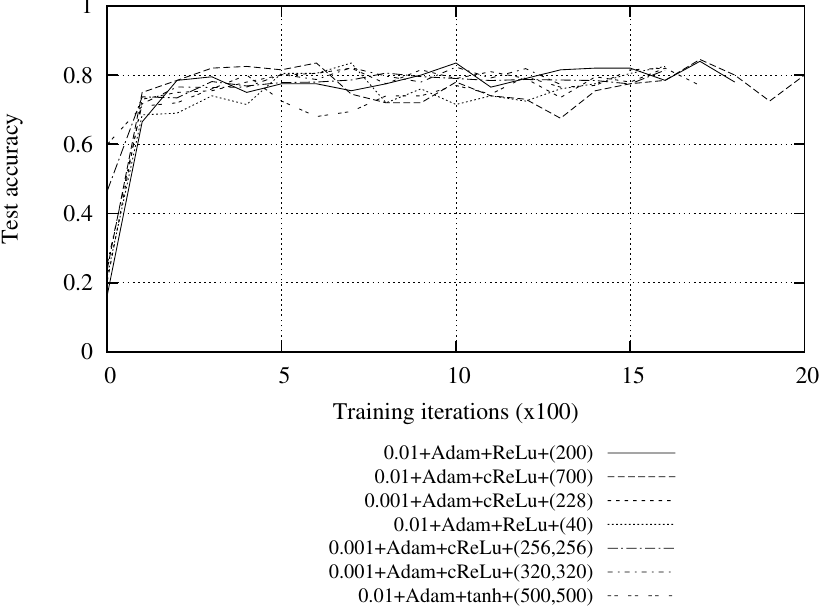
Figure 2. Convergence of a few sample MLP configurations in predicting pass / fail outcomes for individual